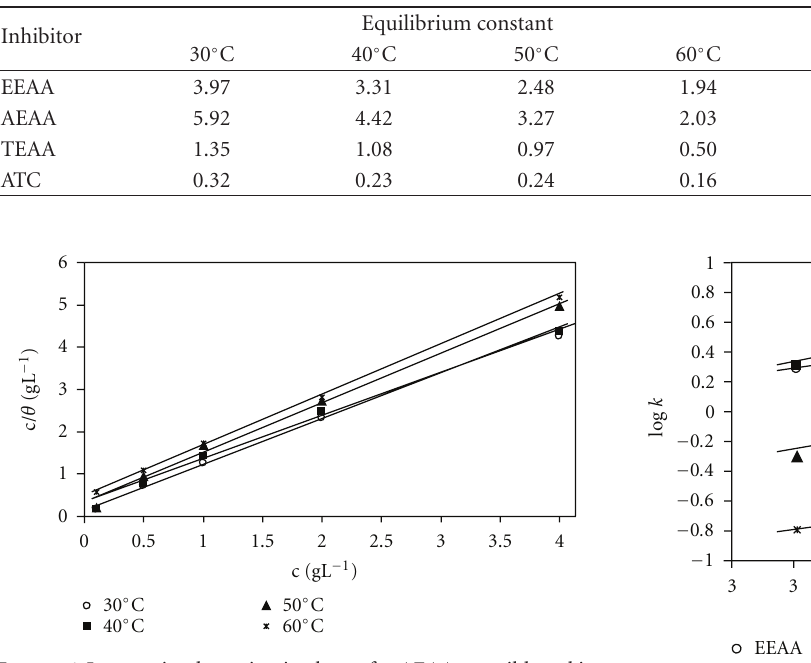
Figure 6: Langmuir adsorption isotherm for AEAA on mild steel in 5M H 2 SO 4 .